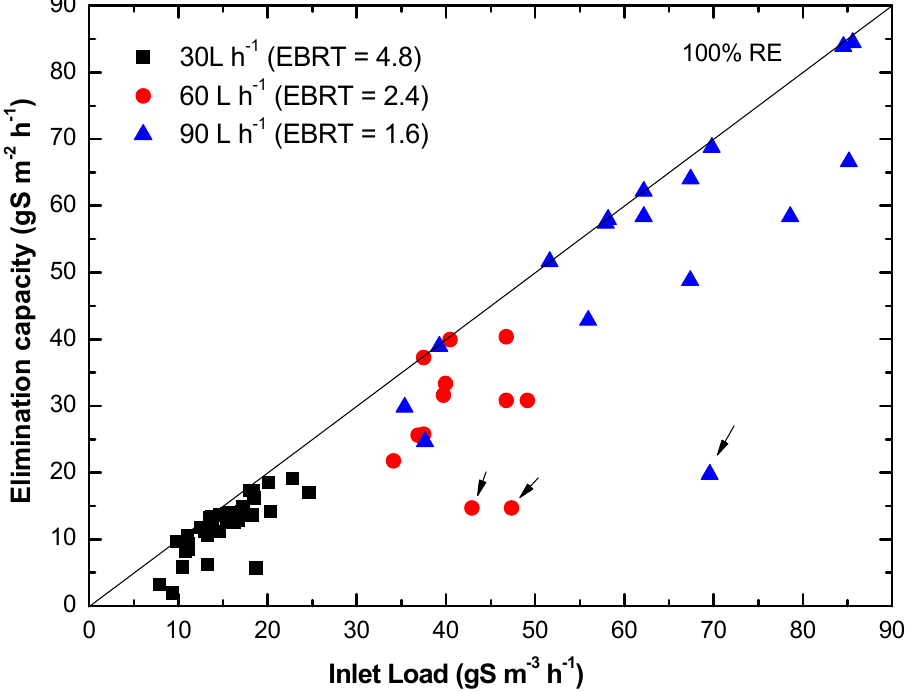
Figure 6. Elimination capacity of the biotrickling filter under different Figure 5. Elimination capacity of the biotrickling filter under different EBRTs.